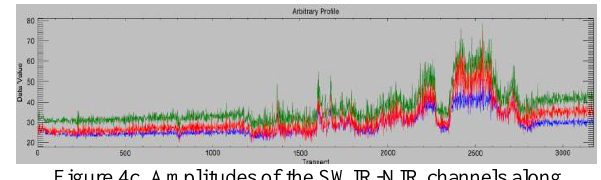
Figure 4c. Amplitudes of the SWIR-NIR channels along transect A-A’ from figure 4a.